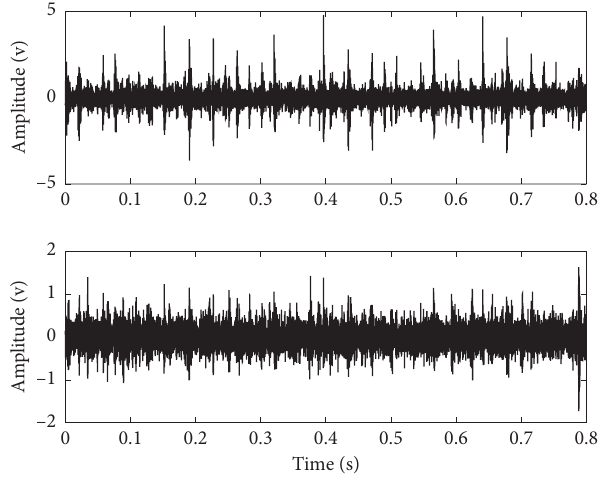
Figure 8: The 2 observed signals [ X ′ ].